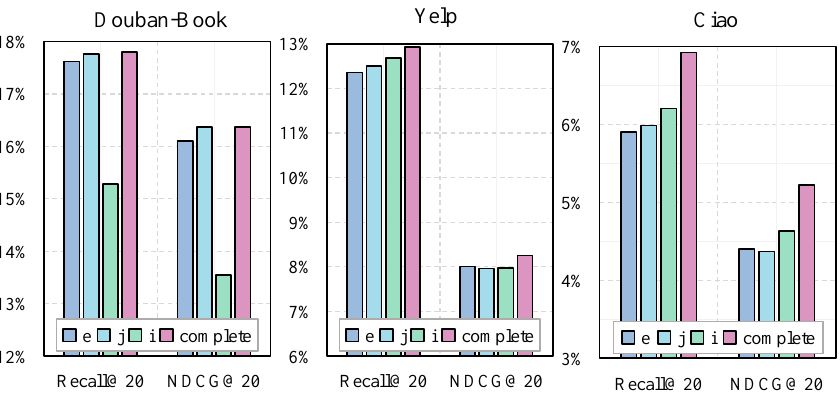
Figure 5. Contributions of each graph with different datasets.